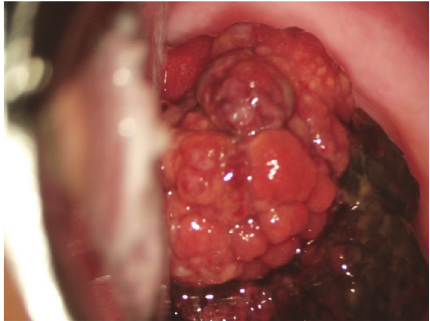
Figure 2: Recurrent polypoid and hemorrhagic irregular tumors filling the vagina and protruding through a cervical